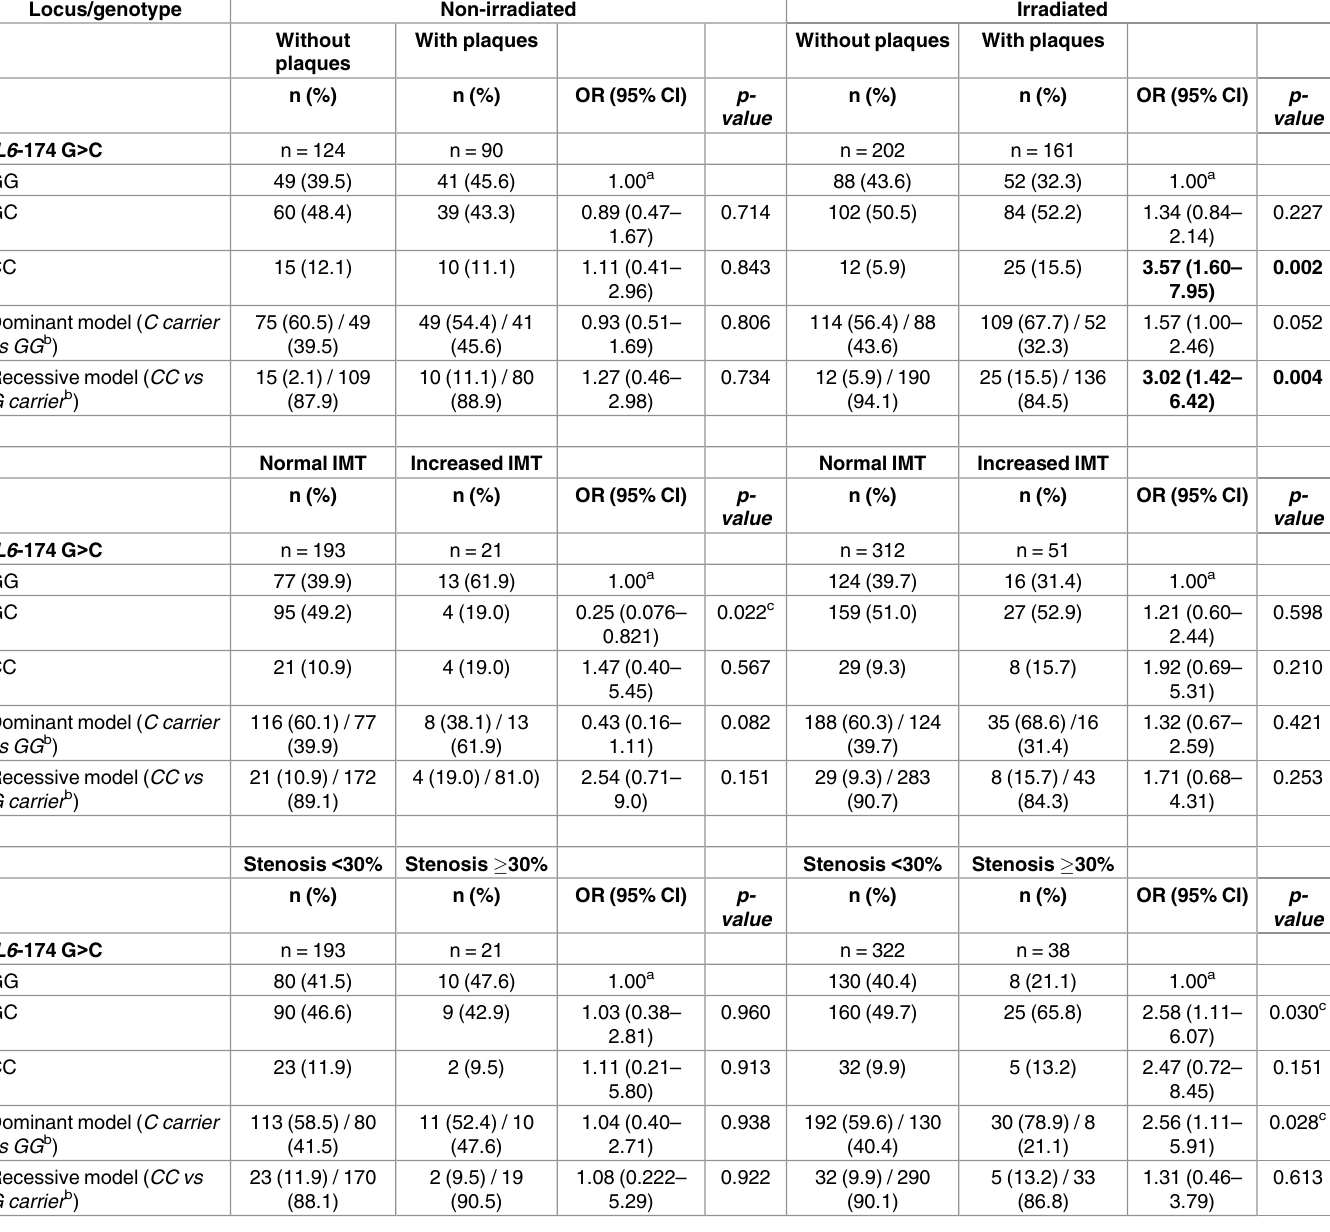
Table 4. Genotypic frequencies and association of the IL6 -174 SNP with presenceof plaques, increased IMT and degree of stenosis, in the irradi- ated and non-irradiated individuals (adjusted for gender, age, hypertension, diabetes, and smoking habits).